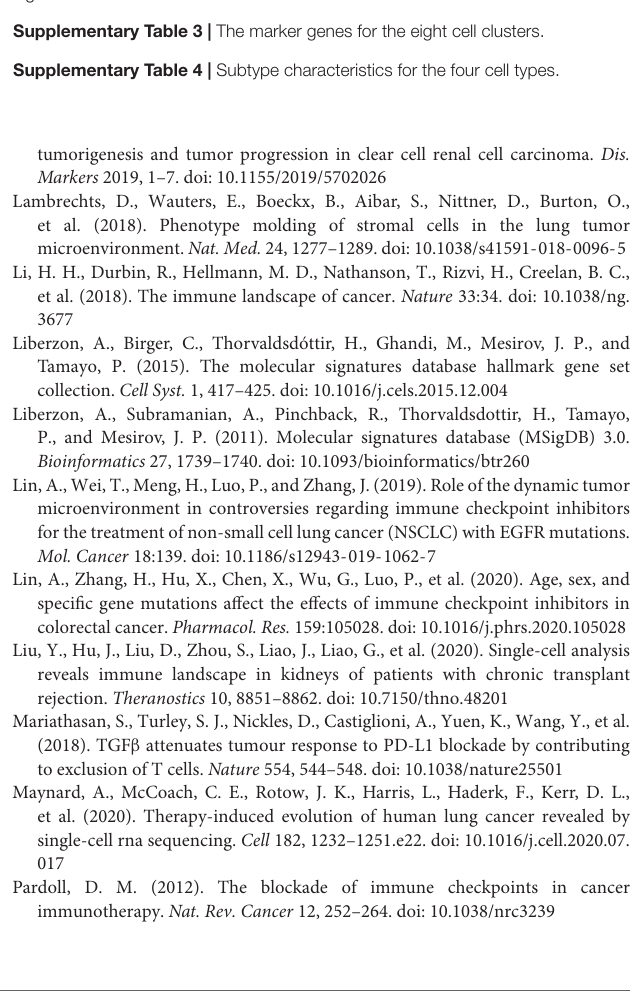
Supplementary Figure 3 | (A) Violin plots showing the smoothed expression distribution of selected genes involved in marker genes of CD8 + T cells/NK cells between tumor core, tumor middle and tumor edge across the CD8 + T cells/NK cells. (B) Violin plots showing the smoothed expression distribution of selected genes involved in marker genes of CD8 + T cells between the tumor core, tumor middle and tumor edge across CD8 + T cells. (C) Violin plots showing the smoothed expression distribution of selected genes involved in marker genes of CD4 + naive T cells between tumor core, tumor middle, and tumor edge across CD4 + naive T cells. (D) Violin plots showing the smoothed expression distribution of selected genes involved in marker genes of Tregs between the tumor core, tumor middle, and tumor edge across the Tregs. Supplementary Figure 4 | (A) tSNE plot, which is color-coded for expression of additional marker genes of CD8 + T cells for the cell types, as indicated. (B) Violin plots showing the smoothed expression distribution of selected genes involved in proliferation between exhausted CD8 + T cells (cluster 0), CD8 + naive T cells (cluster 1), proliferating CD8 + T cells (cluster 2), and proliferating CD8 + T cells (cluster 4). (C) Violin plots showing the smoothed expression distribution of selected genes involved in proliferation between tumor core, tumor middle, and tumor edge tumors across the exhausted CD8 + T cells (cluster 0). Supplementary Figure 5 | (A) tSNE plot, which is color-coded for expression of additional marker genes of B cells for the cell types, as indicated. (B) tSNE plot, which is color-coded for expression of additional marker genes of Langerhans cells for the cell types, as indicated. Supplementary Table 1 | Detailed information on the clinical characteristics of scRNA-seq in LUAD samples. Supplementary Table 2 | The differentially expressed genes between the eight cell clusters. Supplementary Table 3 | The marker genes for the eight cell clusters. Supplementary Table 4 | Subtype characteristics for the four cell